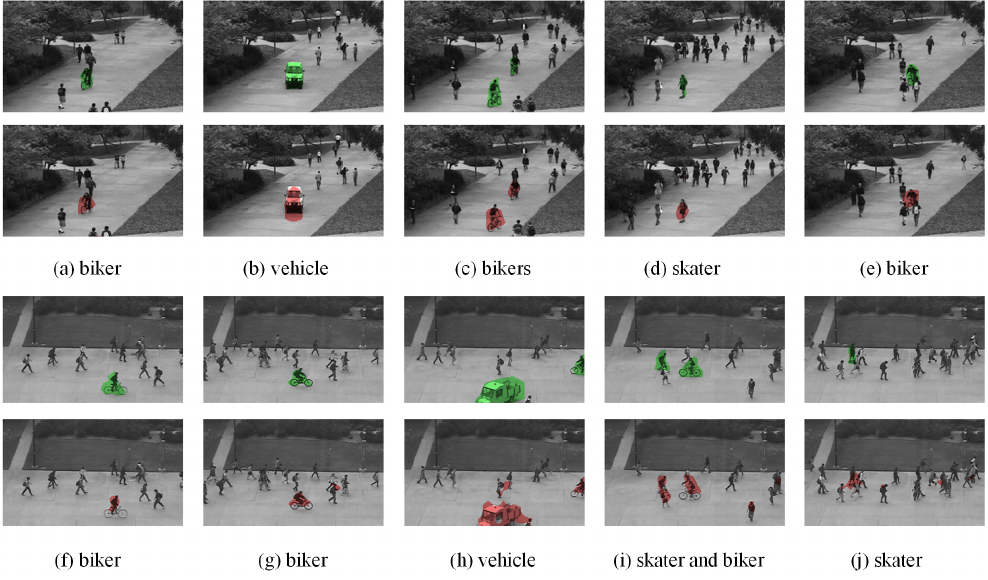
Figure 7. Examples of anomaly detection results on Ped1 (top) and Ped2 (bottom) sequences. The detection results are marked with red color and the groundtruth are with green color.